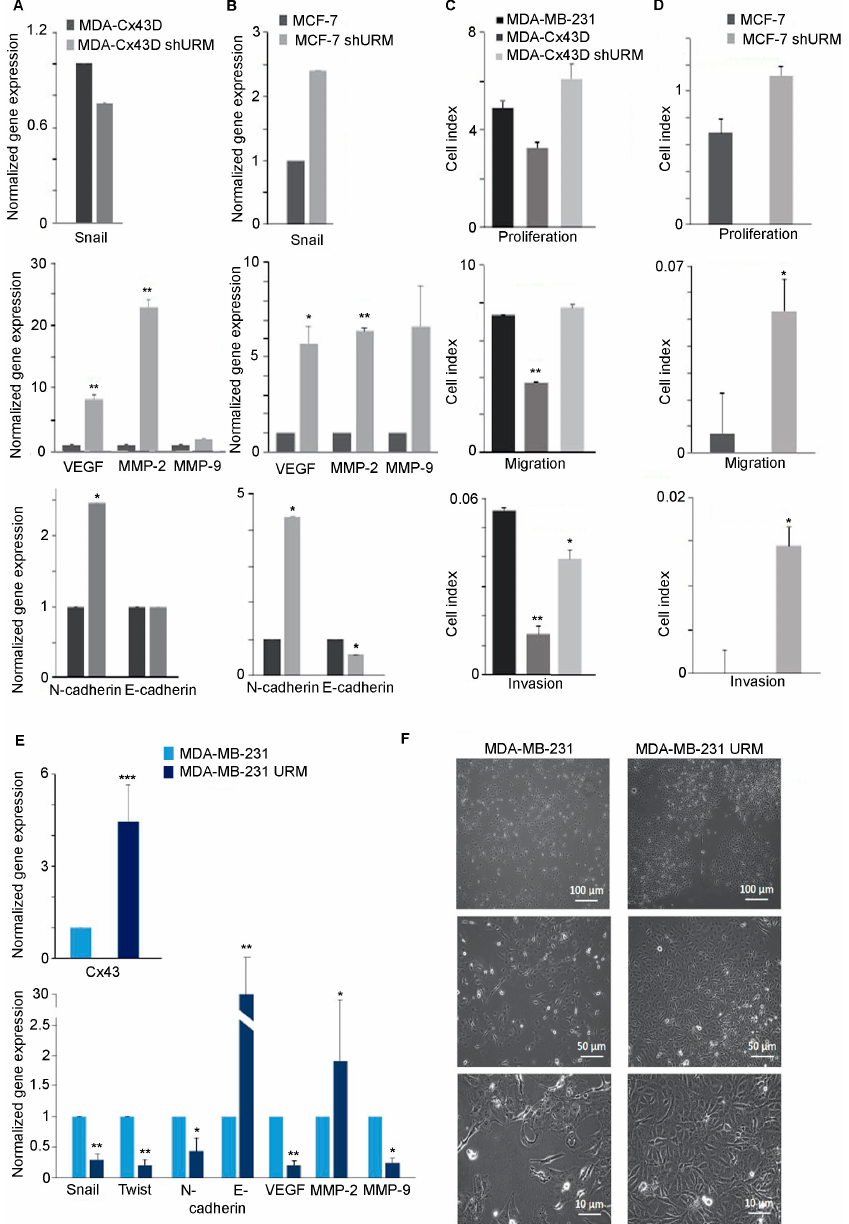
Figure 3. Loss of URM-1 promotes EMT in breast cancer cell lines. ( A ) Transcriptional levels of Snail, VEGF, MMP-2, MMP-9, and N- and E-cadherin in MDA-Cx43D and MDA-Cx43D shURM. VEGF and MMP-2 significantly increased in MDA-Cx43D shURM cells, as shown by qPCR. These cells